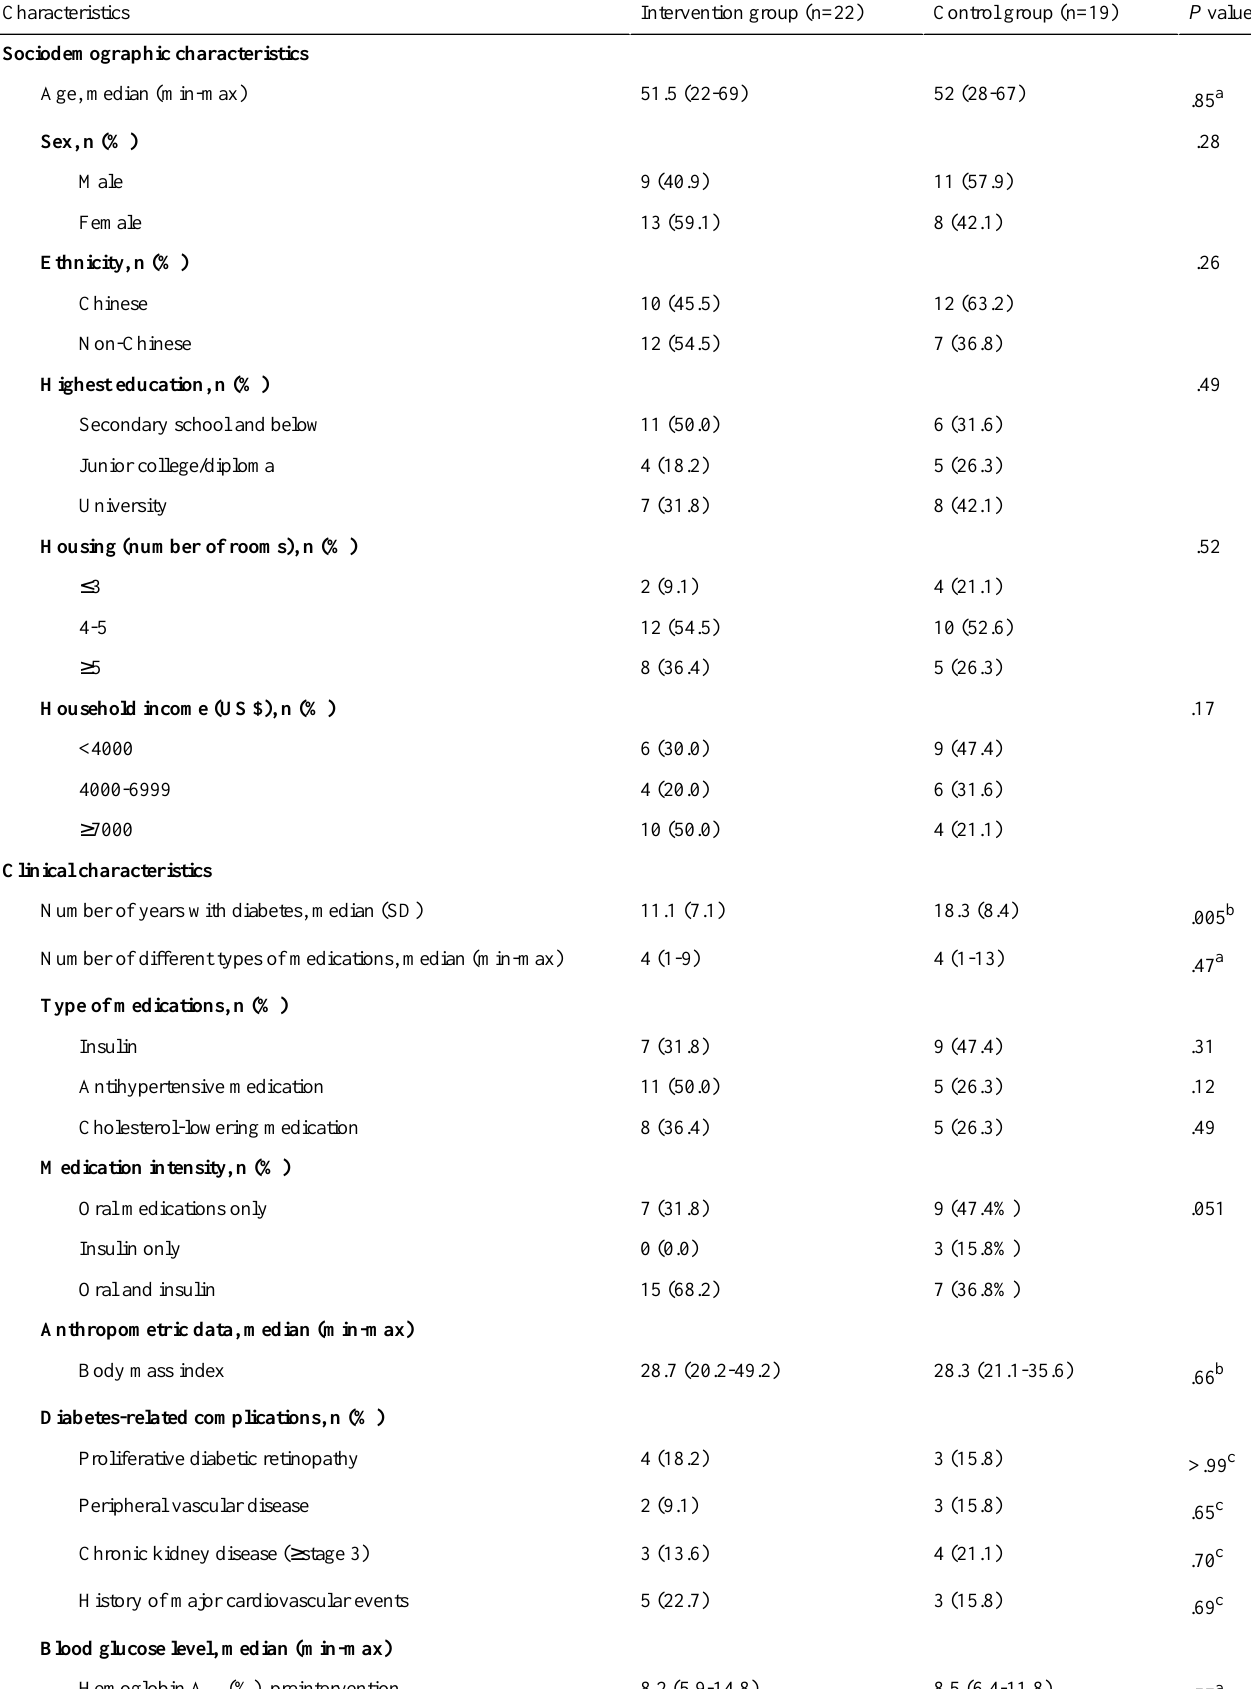
Table 1. Baseline characteristics of patients included in the analyses.